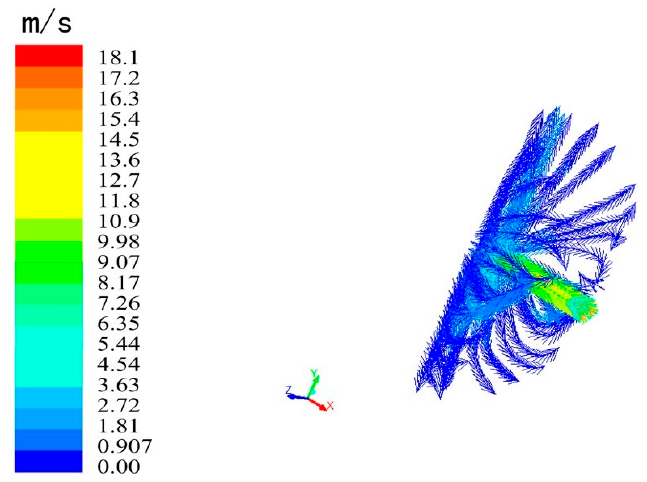
Figure 6. Trajectories around separator entrance.